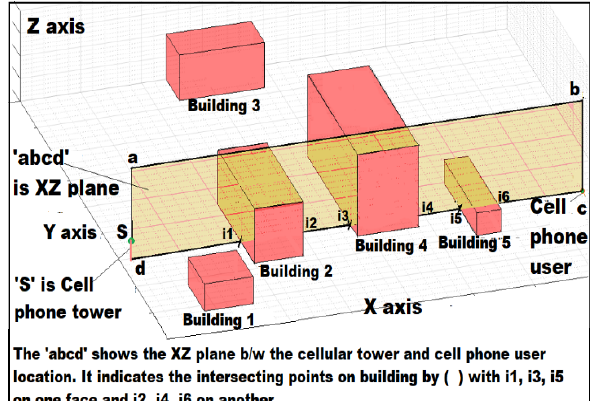
Figure 5. XZ plane intersecting with Building present